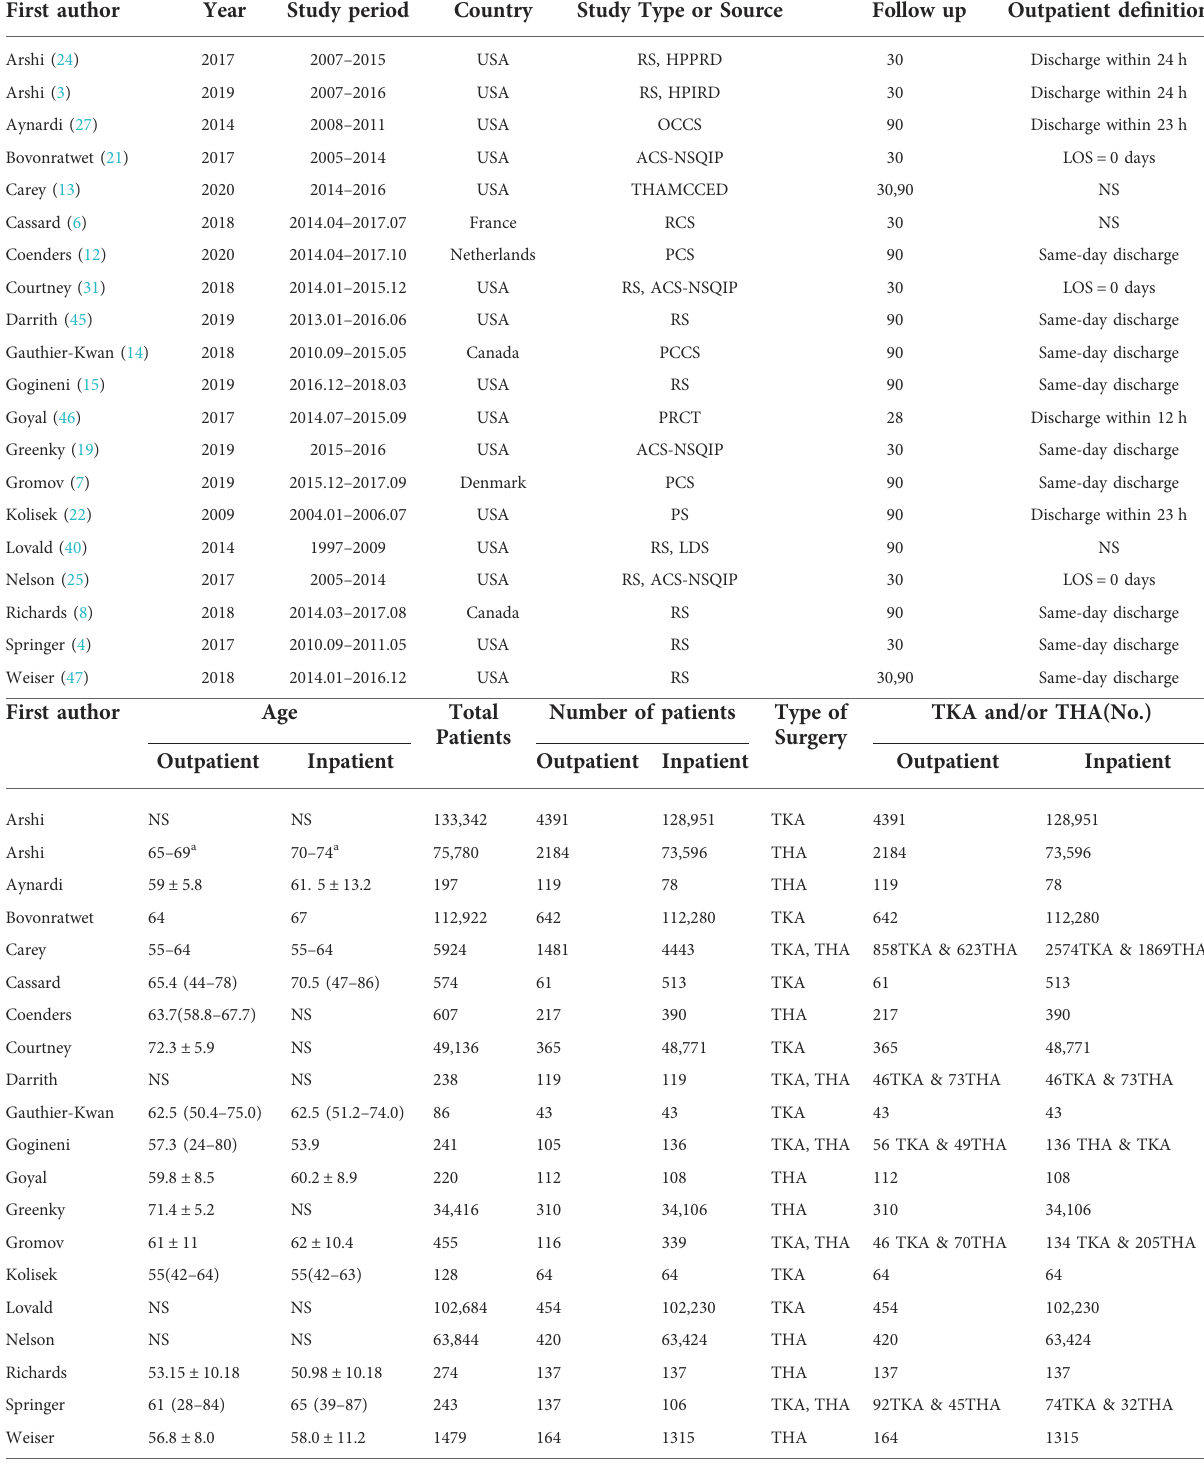
TABLE 1 Demographics and characteristics of the studies included in the systematic review and